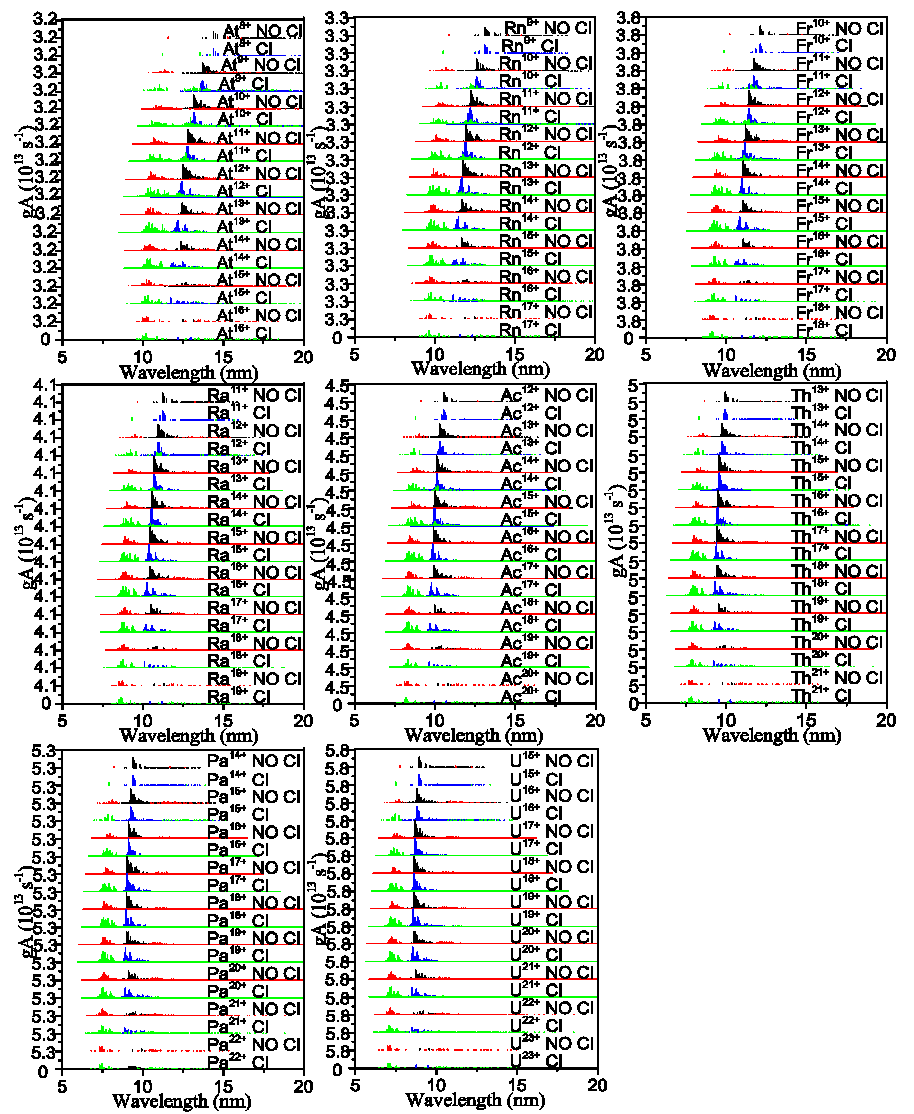
Figure 2. (Color online) Ir-like through Tm-like spectra of At-U calculated with the Cowan Code both including CI (green denotes 5p − 5d and blue denotes 5d − 5f ) and excluding CI (red denotes 5p − 5d and black denotes 5d − 5f ).